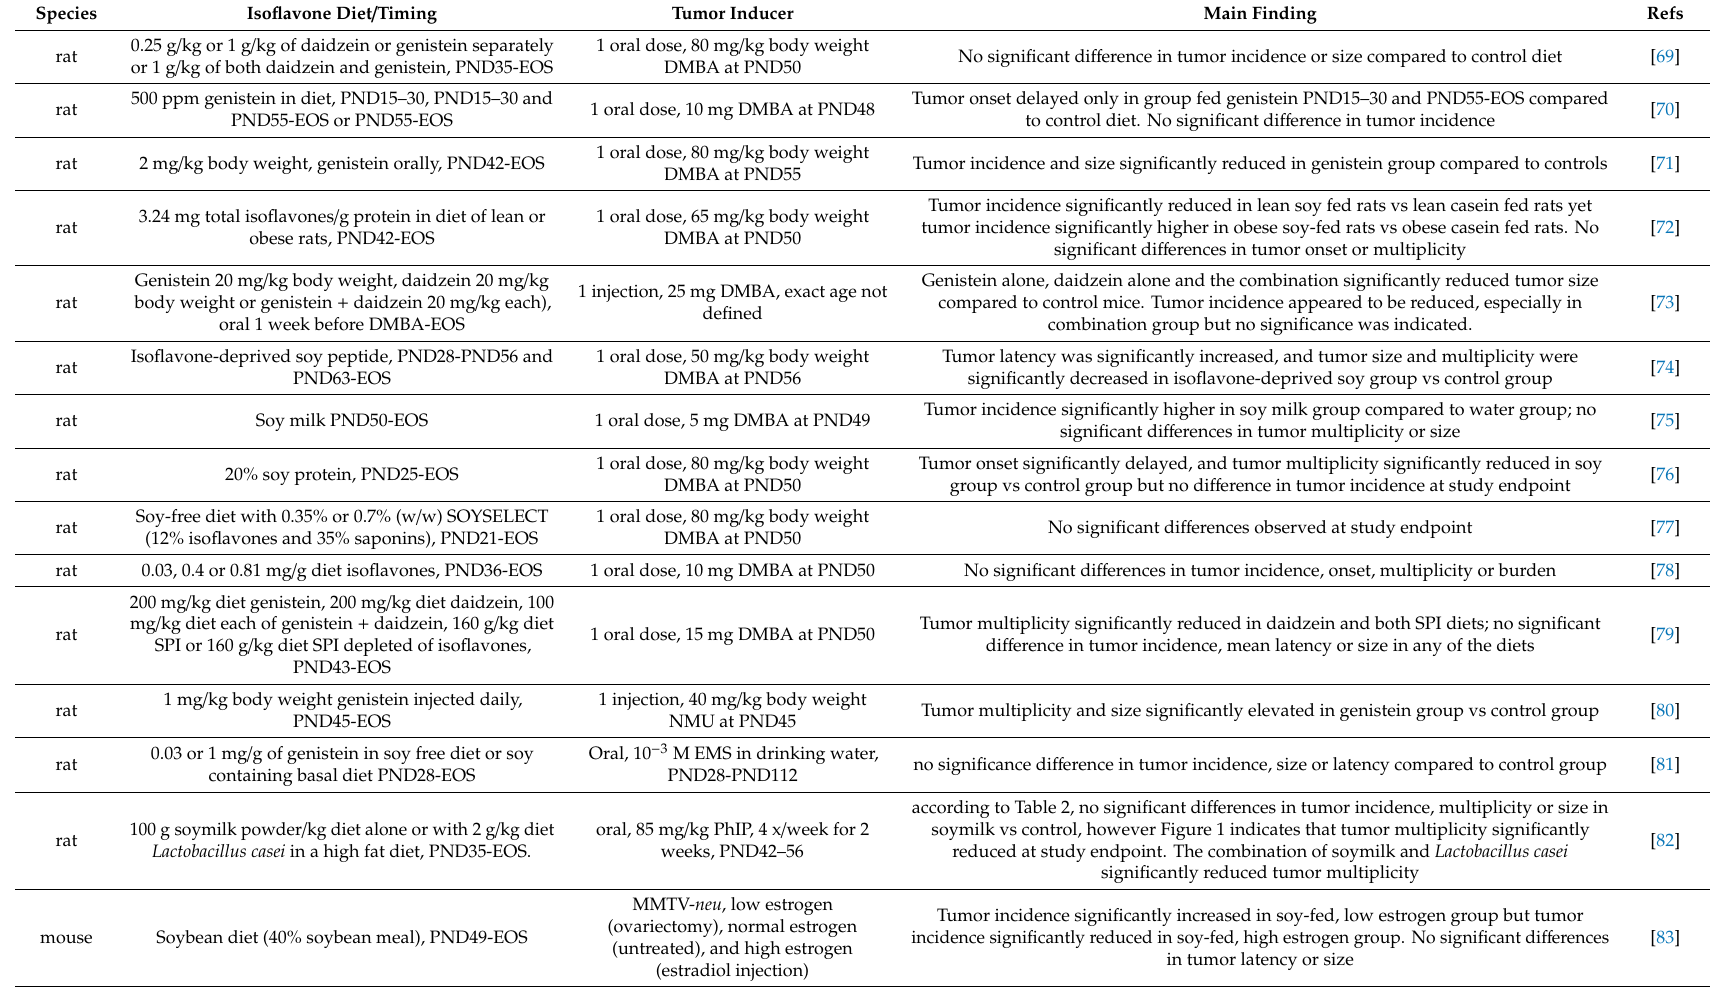
Table 1. Postnatal Soy / Isoflavone